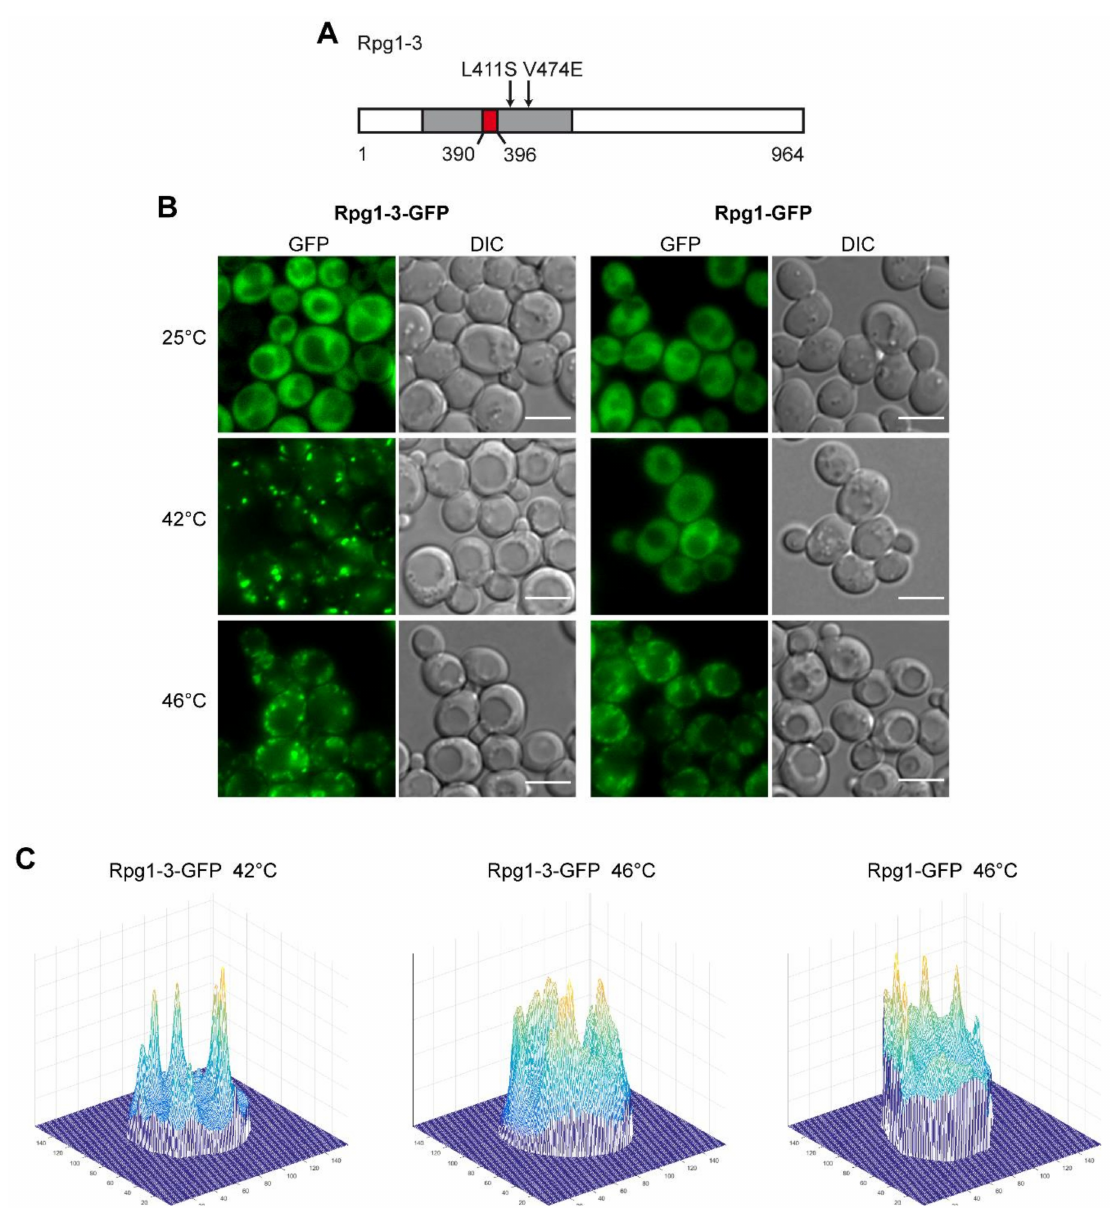
Figure 1. Cellular distribution of Rpg1 and Rpg1-3 upon heat stress. ( A ) A schematic presentation of the Rpg1-3 variant protein. Individual amino acid substitutions are depicted, and the deletion is indicated in red. The position of the PCI domain (amino acids 276–494, [59] is highlighted in gray). ( B ) Live-cell imaging of exponentially growing cells carrying Rpg1-3-GFP and Rpg1-GFP after HS for 30 min at 42 ◦ C and 10 min at 46 ◦ C. Scale bars, 5 µ m. ( C ) Three-dimensional (3D)-brightness projections of typical cells carrying Rpg1-3-GFP after HS at 42 ◦ C and 46 ◦ C, and a representative cell of Rpg1-GFP after HS at 46 ◦